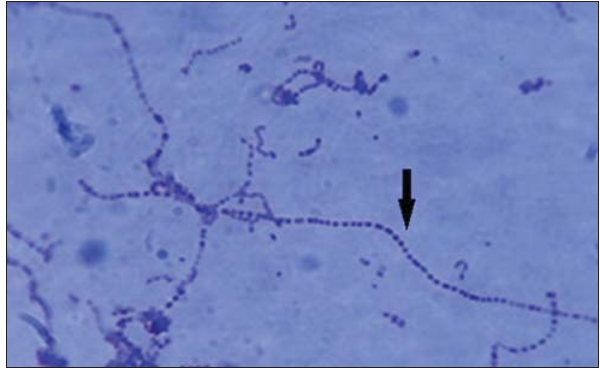
Figure-1: Long chains of Streptococcus equi subsp . equi Gram-staining.